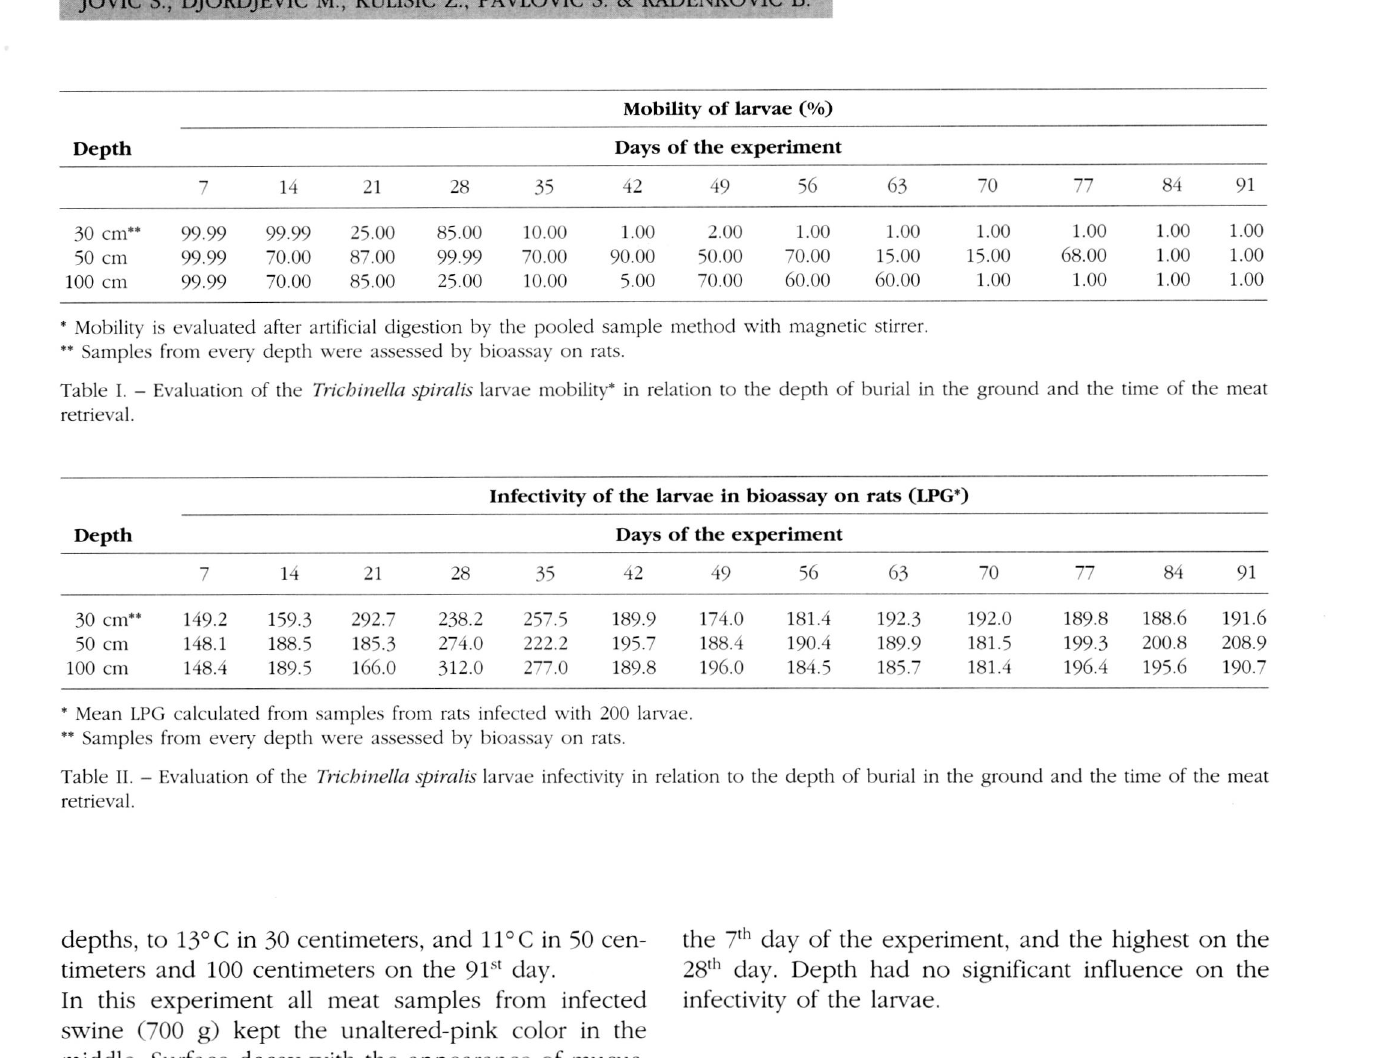
Table I. - Evaluation of the Trichinella spiralis larvae mobility* in relation to the depth of burial in the ground and the time of the meat retrieval.